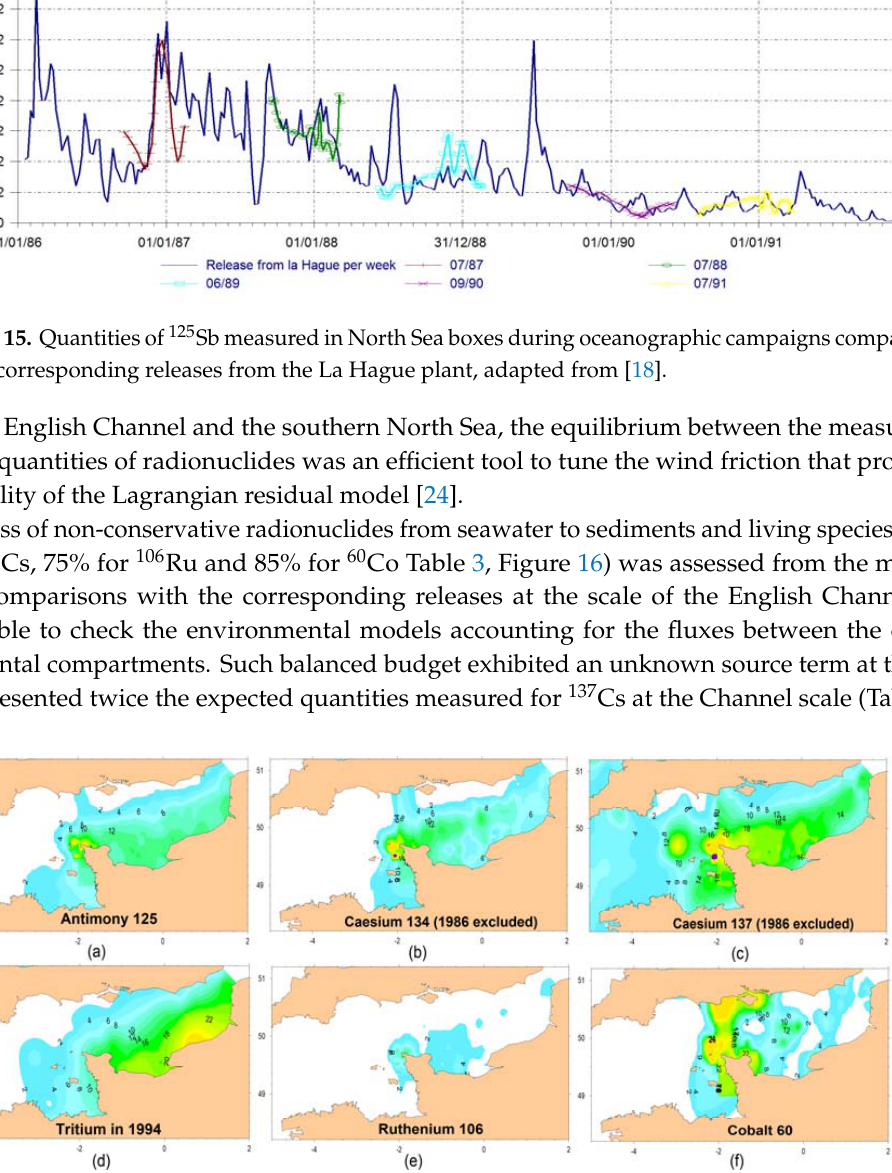
Table 3. Comparison of measured quantities of radioactivity in the English Channel with correspondent releases from La Hague from 1983 to 1994, adapted from [20] . Antimony ‐ 125 is used as reference for the calculation; the background concentrations in Atlantic surface waters ( 137 Cs, 3 H) and Chernobyl fallout ( 137 Cs, 134 Cs) has been deduced.